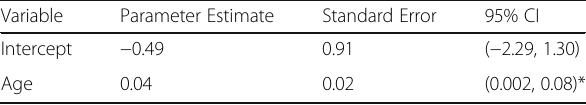
Sex (male vs. female)